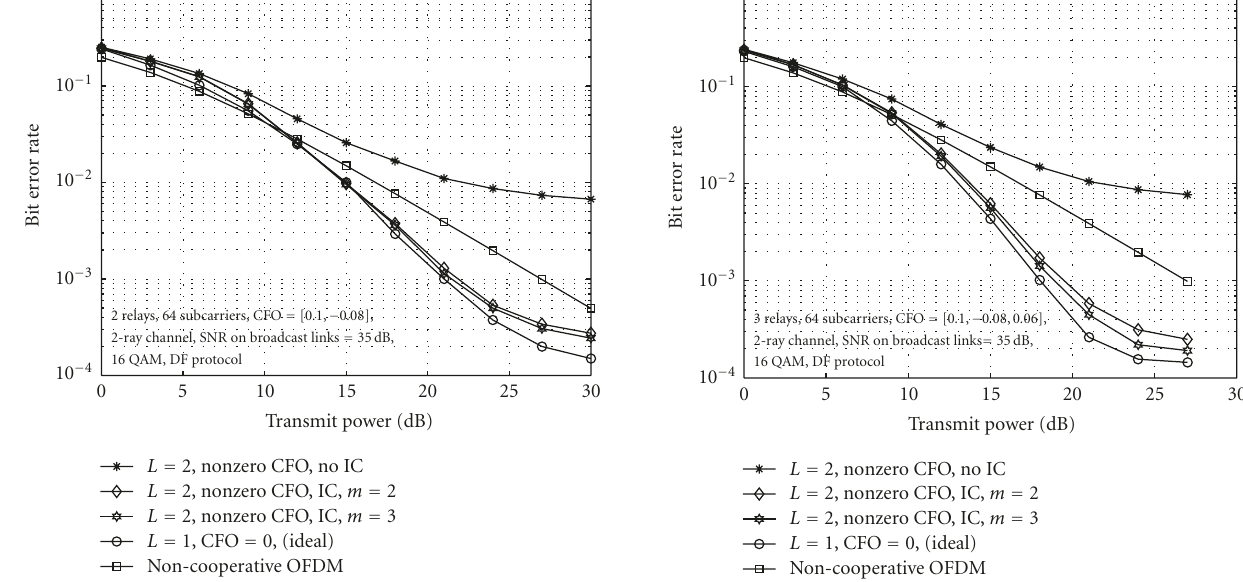
Figure 8: BER performance as a function of SNR for CO-SFBC- OFDM on frequency-selective fading ( L = 2). M = 64, 3 relays ( N = 3, G 3 code), CFO = [0.1, − 0.08, 0.06], 16-QAM, SNR in broadcast links = 35 dB. DF protocol at the relays.